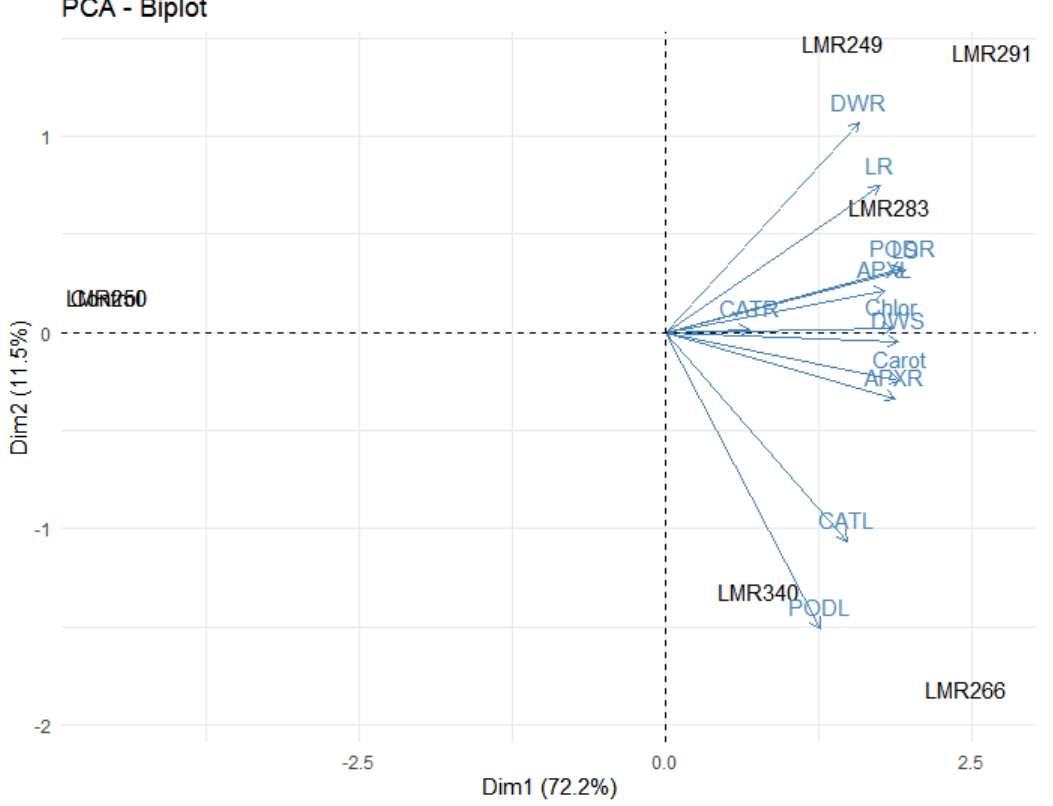
Figure 7. Antioxidant enzymes activities in roots and leaves of Sulla plants 100 days after bacterial inoculation. All the values are means of 4 replicates. One-way ANOVA was performed to deter- mine the influence of inoculated bacteria on antioxidant enzymes for contaminated soil. Means for the different treatments with different letters are significantly different from each other ( p < 0.05) according to the Duncan test.